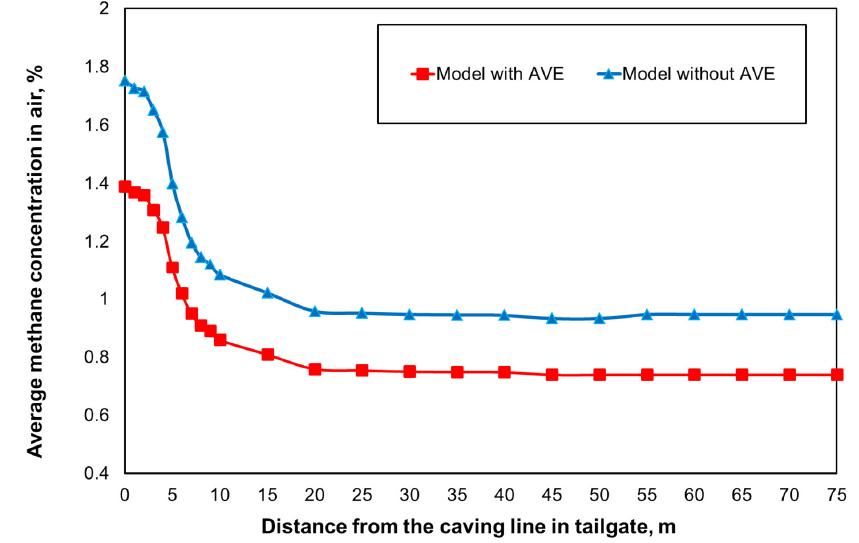
Figure 16. The average values of methane concentrations in the cross-sections of the tailgate for the systems with and without AVE.